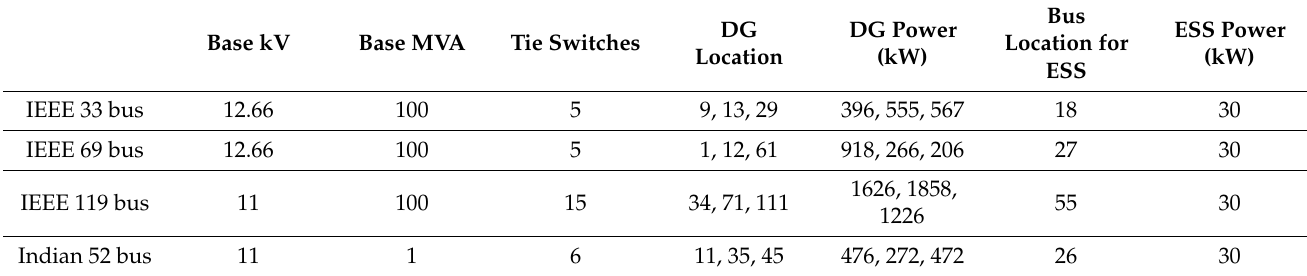
Figure 3. Different load profiles for systems are taken into consideration. Table 1. Specifications of the test